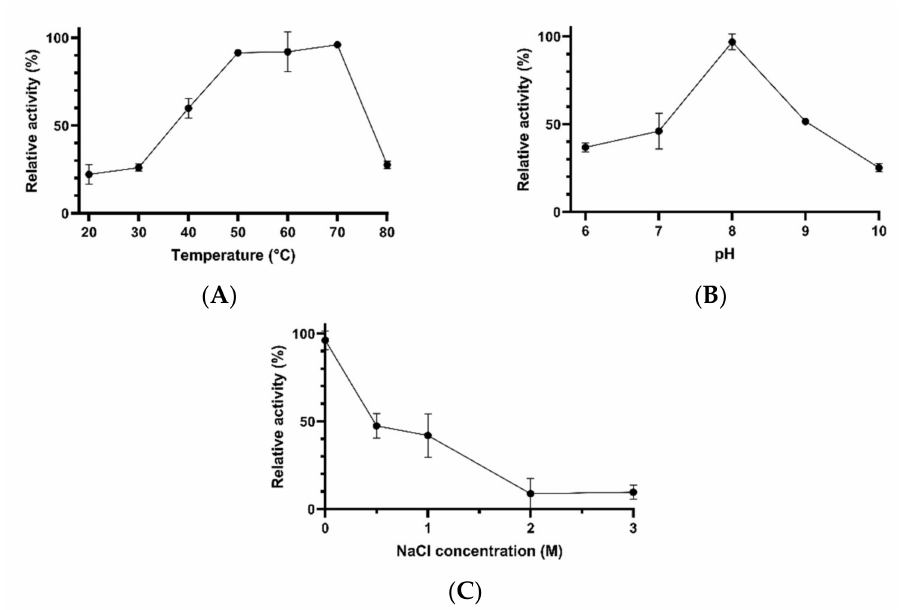
Figure 3. The effects of temperature ( A ), pH ( B ) and NaCl concentration ( C ) on the activity of concentrated proteases obtained from Bacillus sp. AM N P1.17. Error bars represent the standard deviation of the mean ( n =